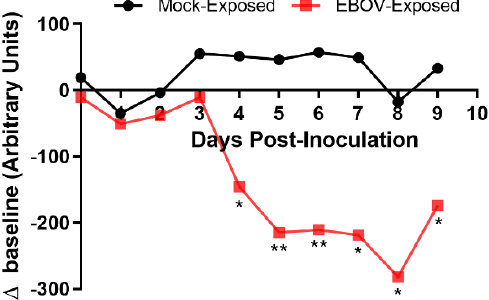
Figure 5. Group means of 12-h light period activity (movement in cage). Twelve-hour light period activity monitoring by telemetry occurred from 06:00 to 18:00. * p < 0.05; ** p < 0.001. p -values are indicated for comparison of change-from-baseline values in mock- vs. EBOV-exposed animals on the indicated study day.